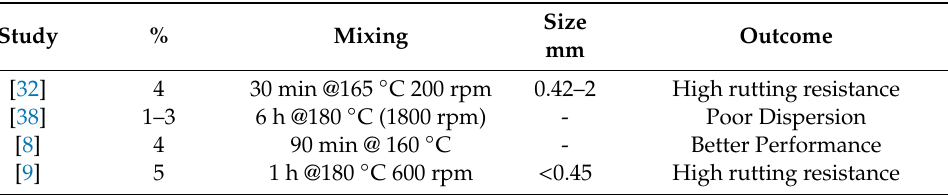
Table 1. HDPE Bitumen Mixing recommendation.